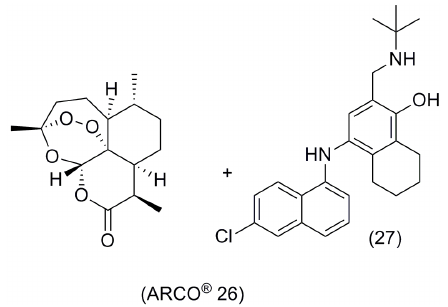
Figure 11 - Structure of drugs used in ARCO ® combination 26 .